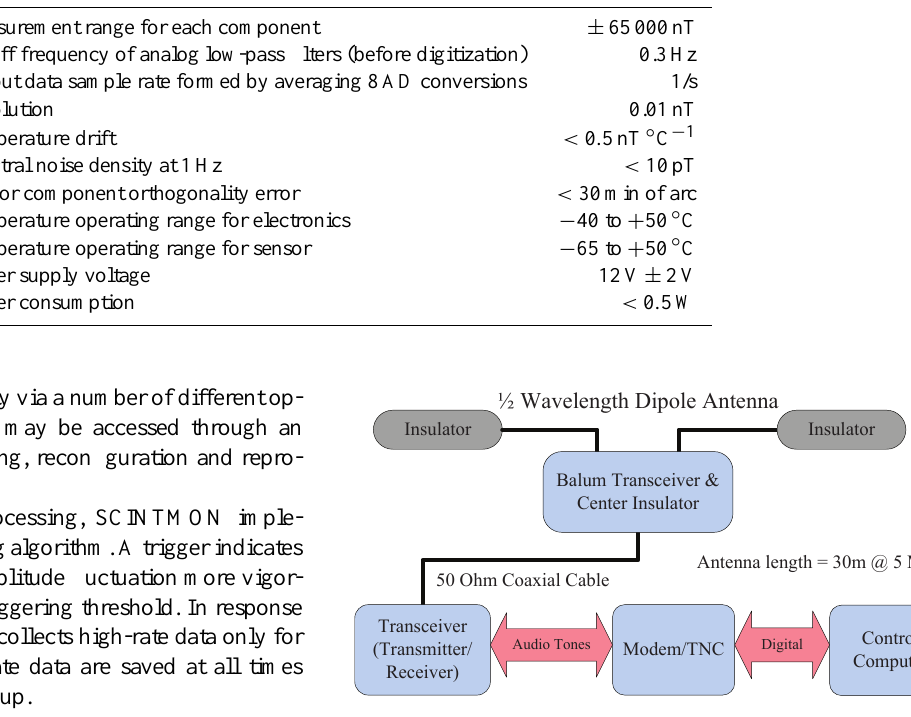
Figure 12. HF radio